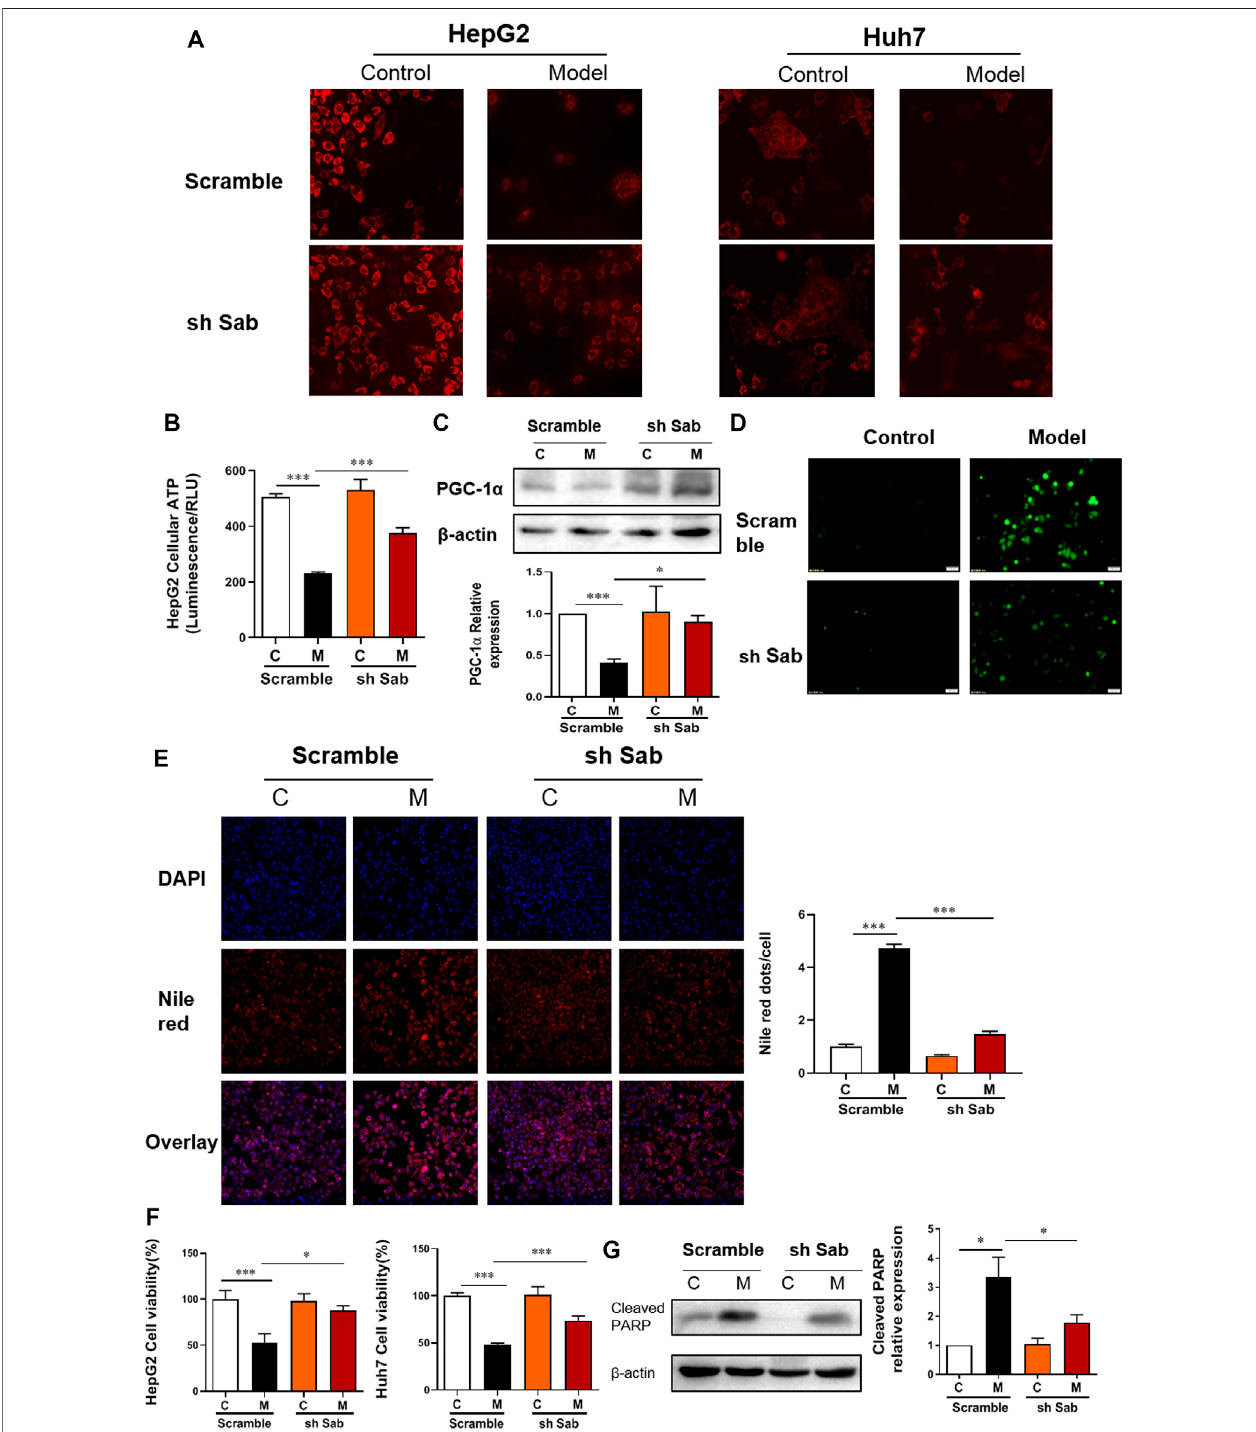
FIGURE 2 | Sab knockdown improved PA-induced mitochondrial dysfunction and lipotoxic injury of hepatocytes. (A) TMRM staining of HepG2 and Huh7 cells (200×). (B) The ATP production of HepG2 cells. (C) PGC-1 α protein expression of HepG2 cells. (D) ROS level of HepG2 cells (200×). (E) DAPI and Nile Red double staining of HepG2 cells (200×). (F) The effect of Sab knockdown on HepG2 cell viability with PA induction. (G) The effect of Sab knockdown on Cleaved PARP level in HepG2 cells. * p < 0.05, *** p < 0.001.